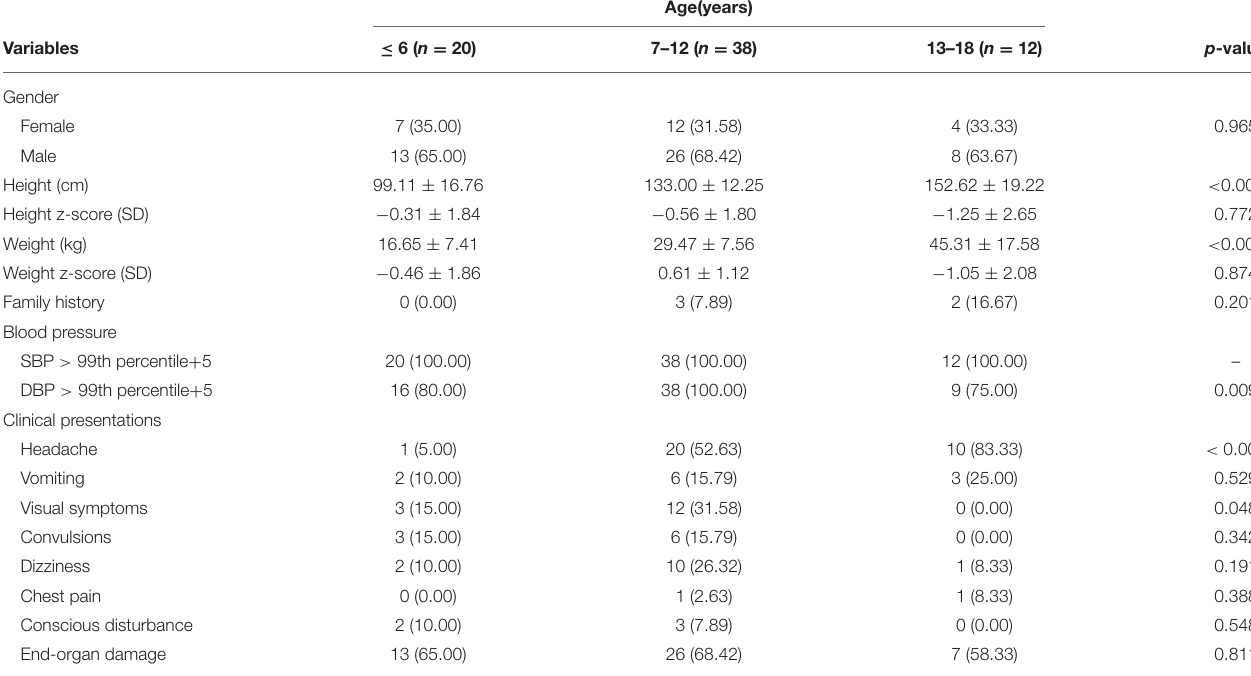
TABLE 1 | Characteristics of the patients with hypertensive crisis by age group.